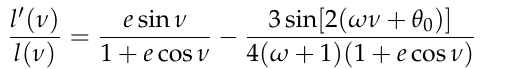
Figure 6. Log ratio of tether length versus